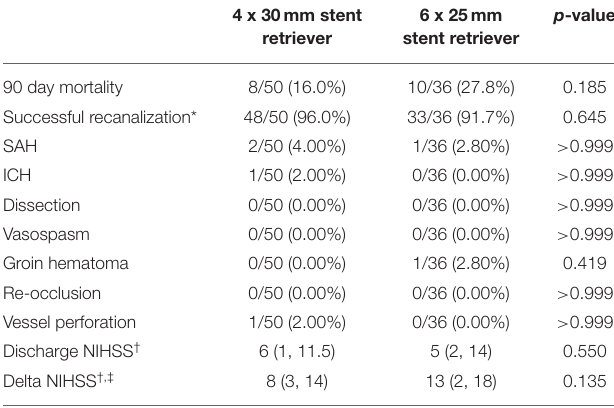
TABLE 2 | Outcomes.